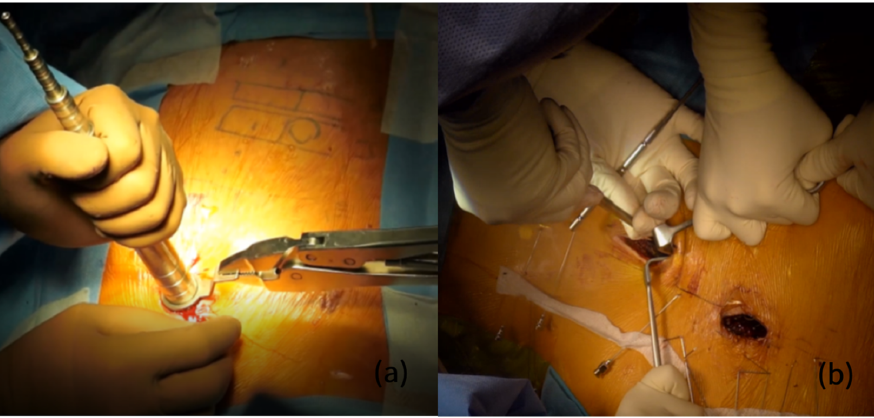
Figure 1. ( a ) Placement of tubular retractor to expose the targeted facet joints. ( b ) Exposing the surgical field using right-angled retractors with various lengths and widths.